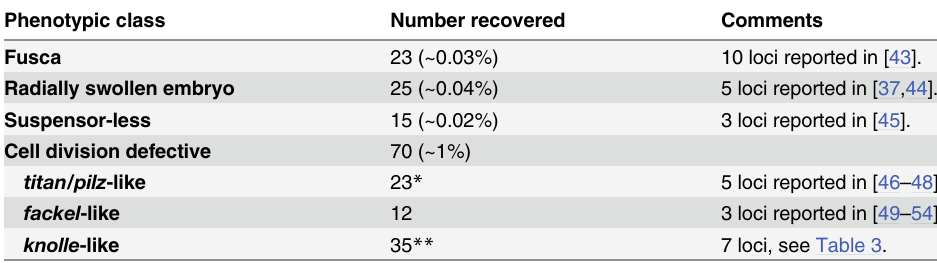
Table 2. Frequency of selected embryo-defective